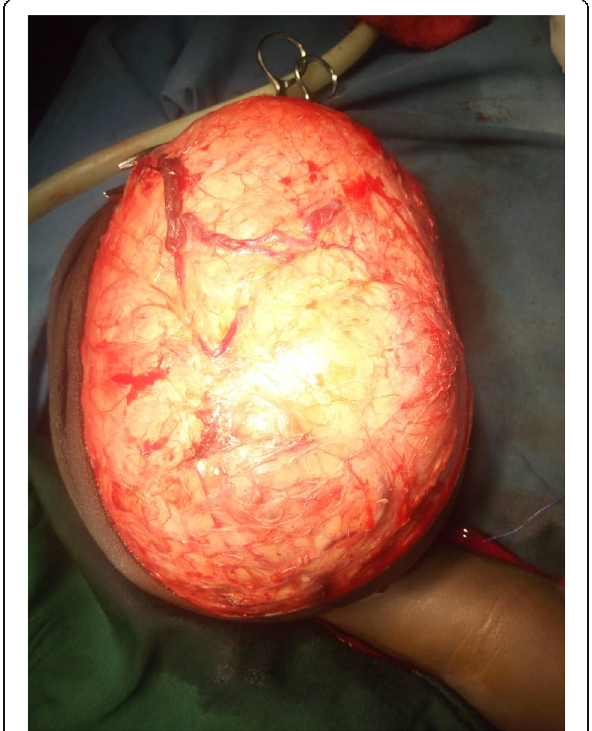
Fig. 2 Intra-operative picture during excision of axillary lipoblastoma